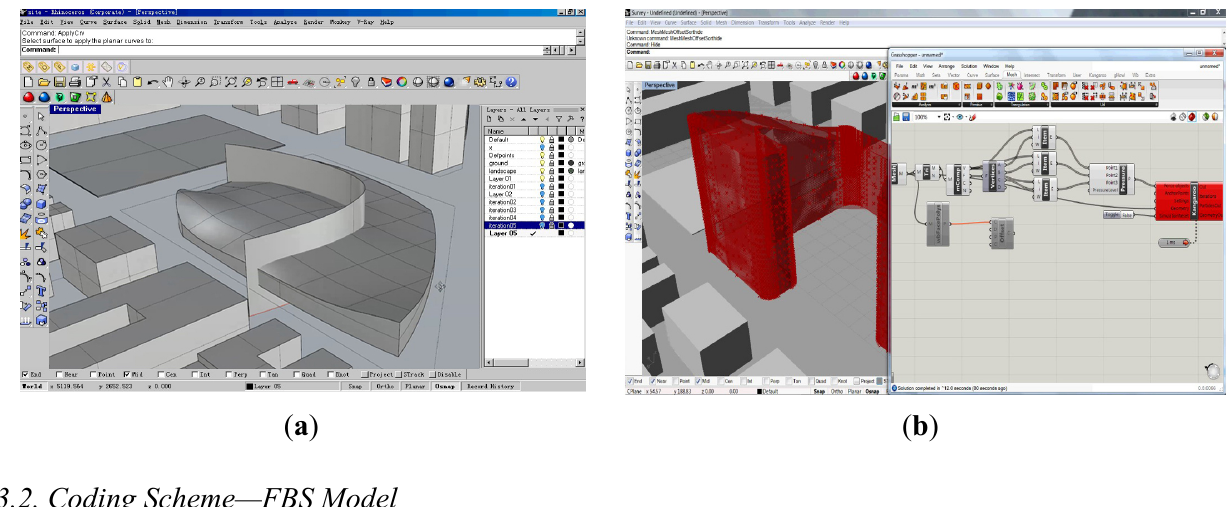
Figure 1. ( a ) Geometric modeling environment (GME), and ( b ) Parametric design environment